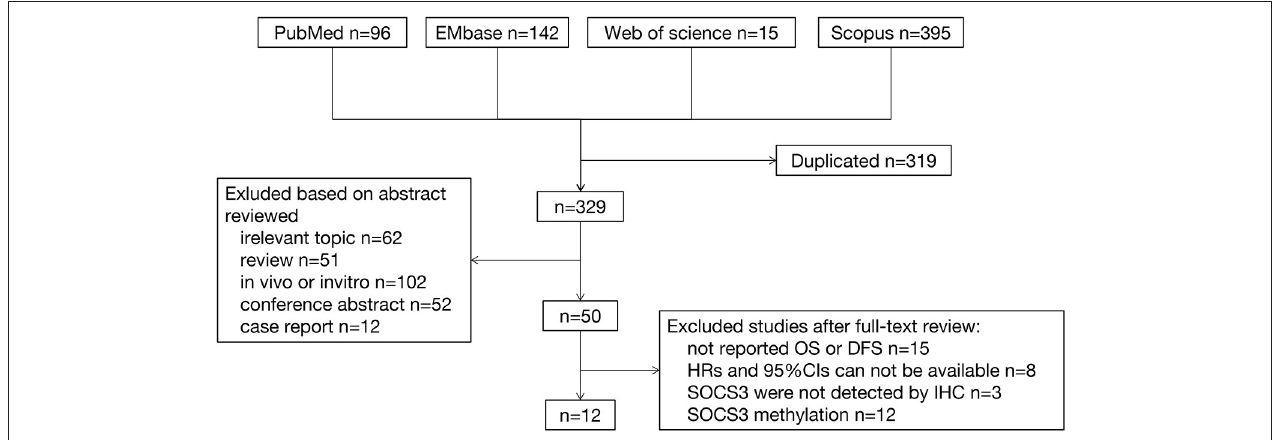
FIGURE 1 | Flow of studies selection.